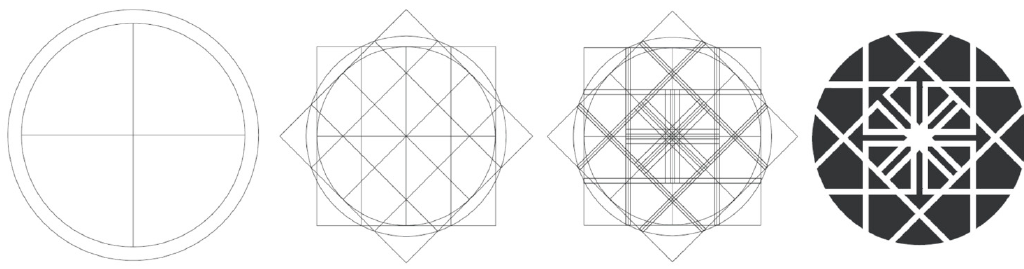
Figure 12. Good continuation.